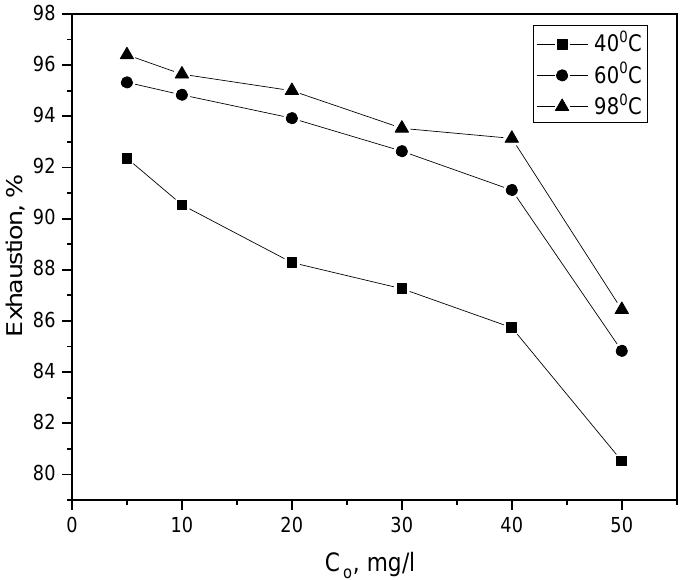
Figure 1. Influence of initial dye concentration on the degree of dye exhaustion during dyeing